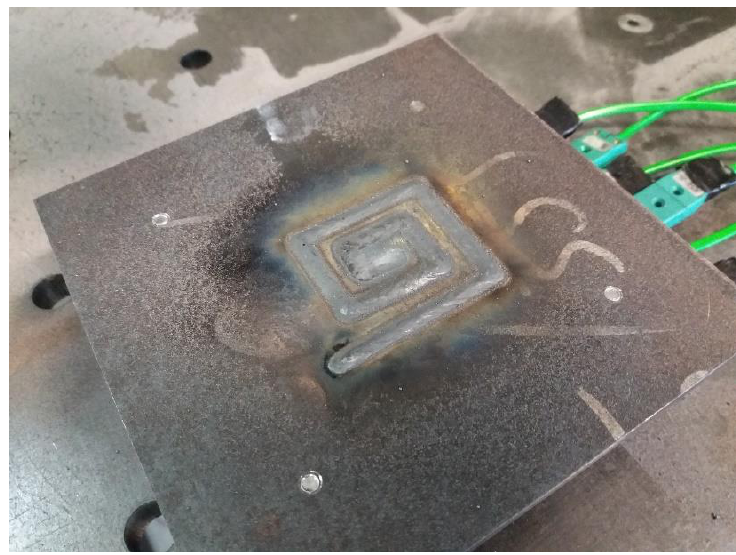
Figure 9. Experiment: cladding of a three-layer square spiral at RAPTECH.